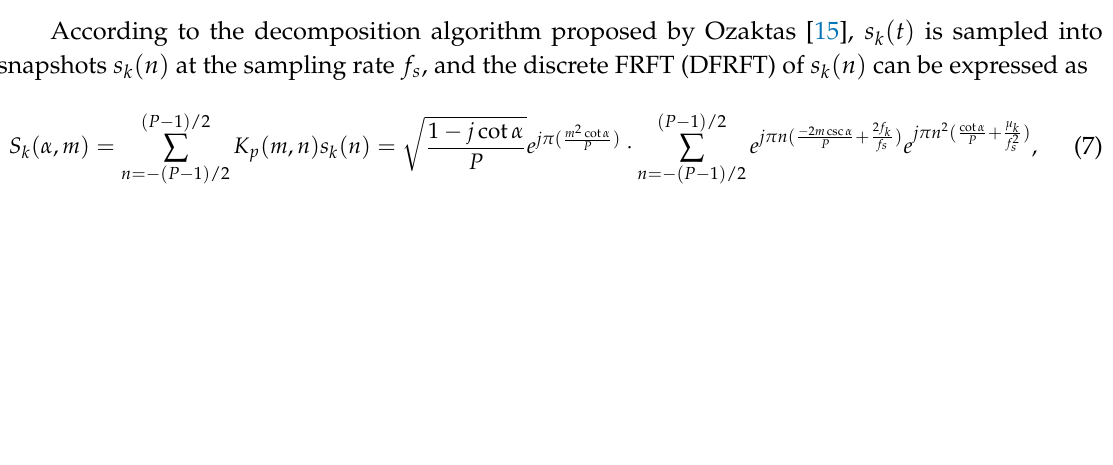
Figure 2. The spectrum for the DFRFT of the k th wideband LFM